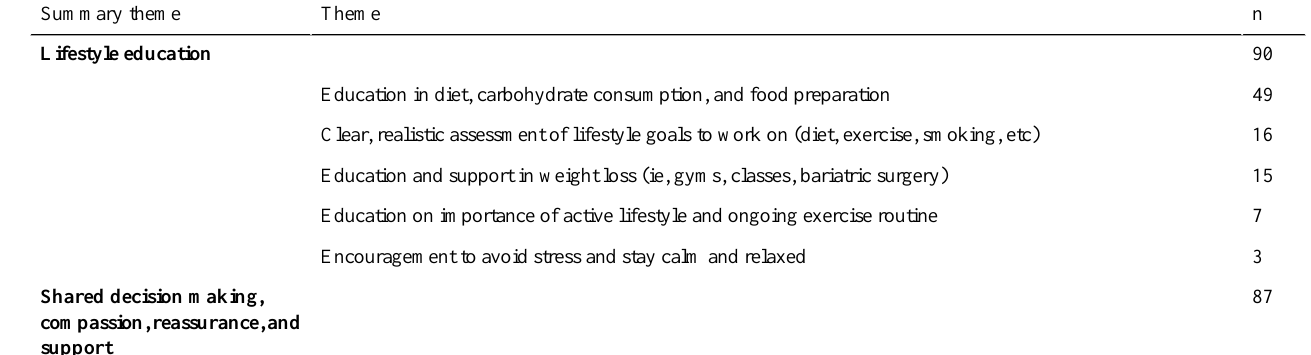
Table 3. Summary themes for responses to the question, “Thinking about when you were first told you had diabetes, what was or would have been most helpful for you to know about your diabetes at that time?” (n=299).